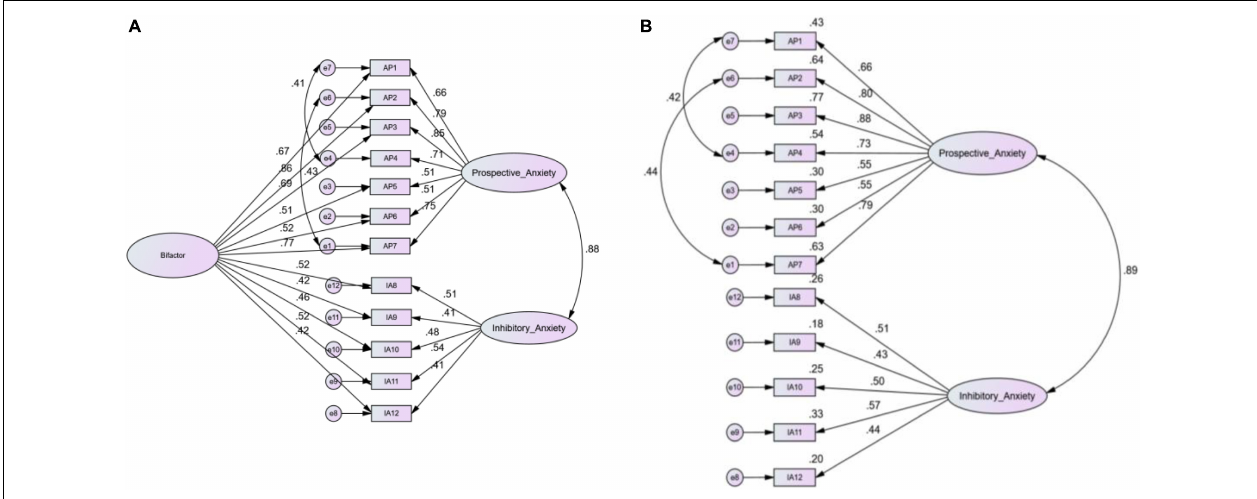
FIGURE 1 | The intolerance of uncertainty scale-12 construct Model (A) (bifactor model) and the IU-12 construct Model (B) with two sub scales.